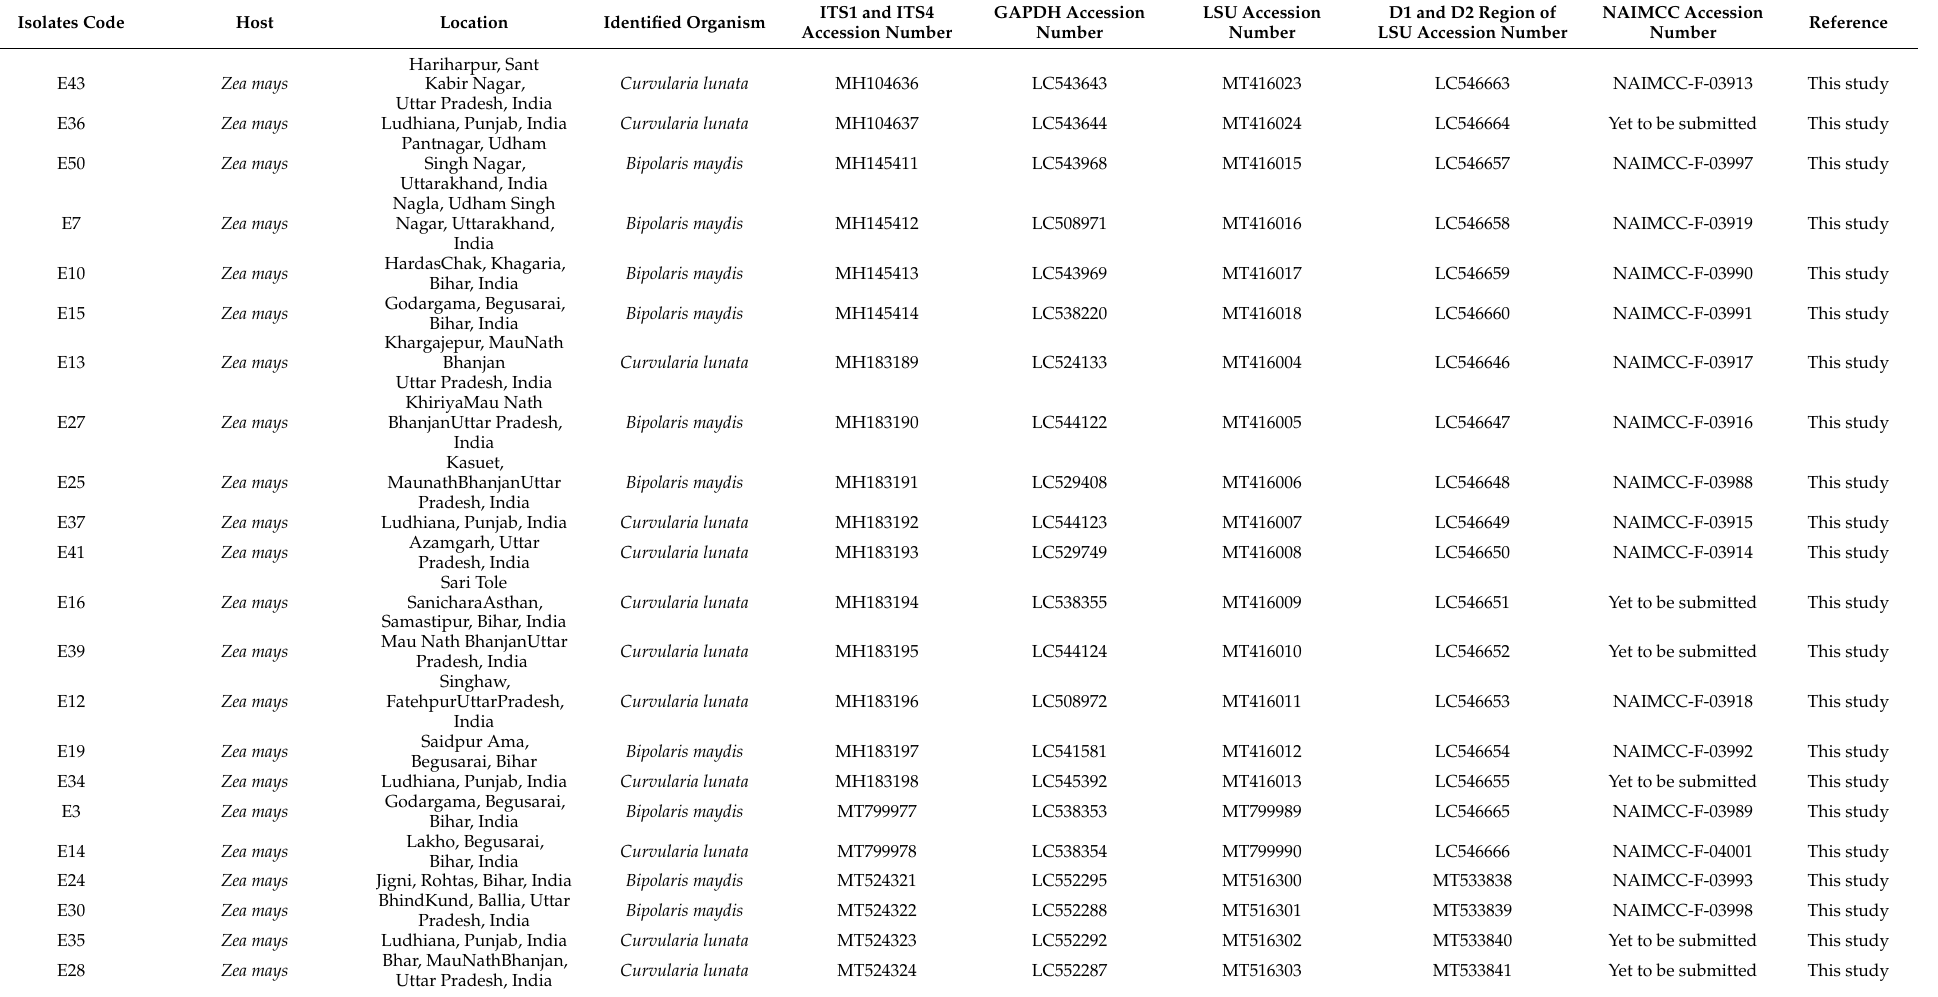
Table 2. Details of the isolates used in this study, including the hosts, locations, and GenBank accession numbers of the generated sequences of the ribosomal marker (ITS, LSU, and D1 and D2 region of LSU) and protein-coding gene